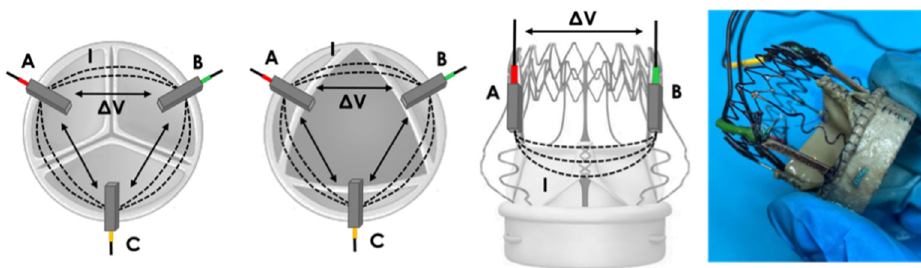
Figure 5. Prototype 2: positioning of “bar” electrodes A (red), B (green) and C (yellow). Local electric field lines (I) and the corresponding potential difference measurement ( Δ V) are represented for each pair of electrodes.